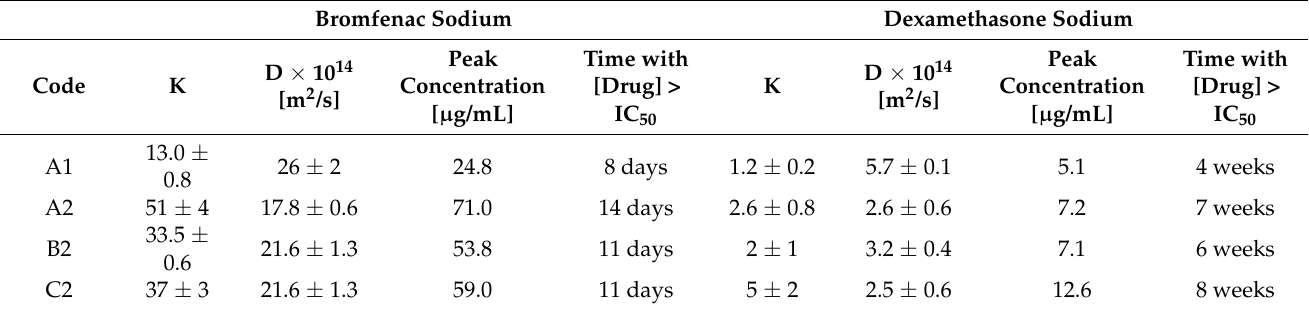
Table 5. Input parameters to the mathematical model (partition coefficient K and effective diffusivity D) for the prediction of the in vivo drug concentration in the aqueous humor, peak drug concentration and therapeutic lifespan of the designed hydrogels. Hydrogel codes as in Table 1.